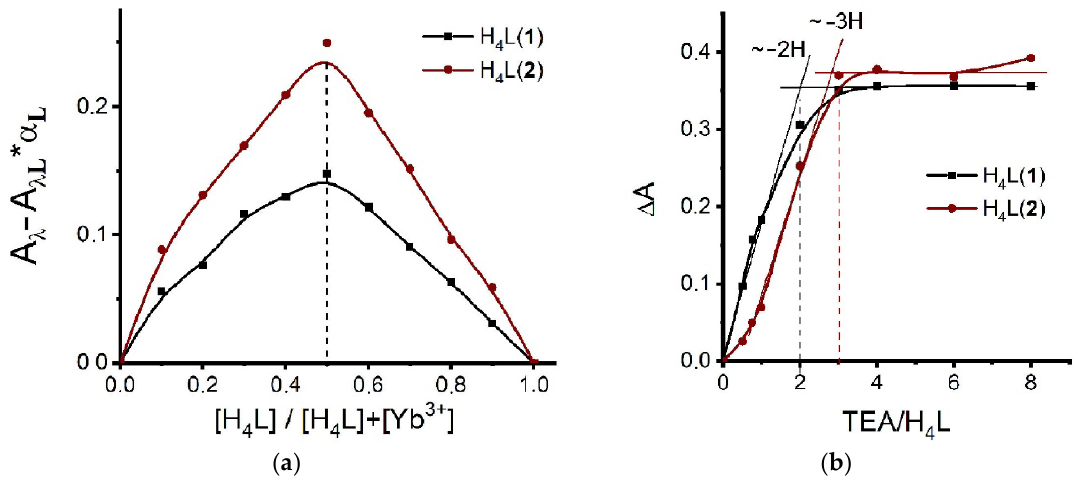
Figure 5. The Job’s plot profiles of DMF solutions at the varied H 4 L:Yb 3+ molar ratios: ( a ) H 4 L( 1 ) (λ = 340 nm), H 4 L( 2 ) (λ = 350 nm) ([H 4 L] + [Yb 3+ ] += 0.1 mM, L:TEA (1:8)); ( b ) ∆ A of the DMF solutions of H 4 L with Yb(NO 3 ) 3 at the varied TEA:L molar ratios: H 4 L( 1 ) (λ = 340 nm), H 4 L( 2 ) (λ = 350 nm). C Yb 3+ = C H4L = 0.1 mM.